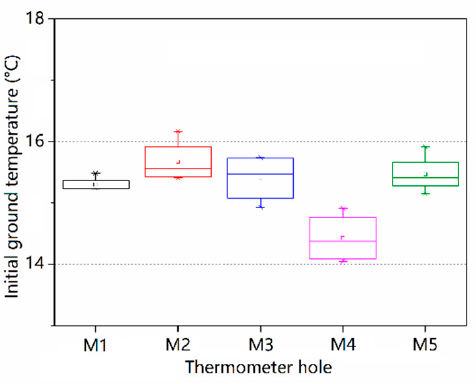
Figure 9. The box chart of initial ground temperatures in different thermo-observation holes.